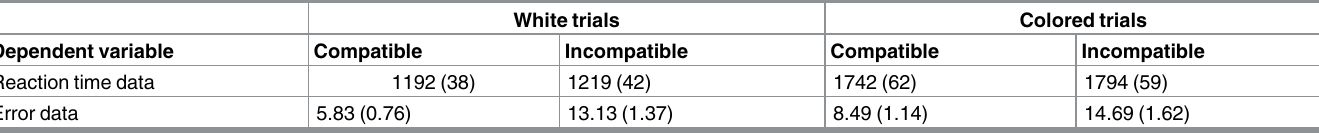
Table 1. Mean response latencies (in ms) and mean error rates (in percentages) as a function of trial type and compatibility in Experiment 2 ( SE in parentheses). White trials Colored trials Dependent